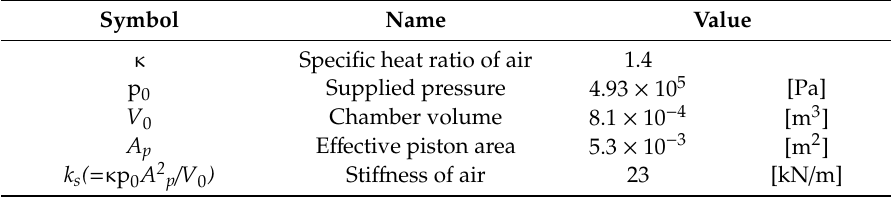
Figure 12. Experimental setup used for the measurements of the complex stiffness of pneumatic spring k *exp . Table 2. Design specifications of the employed pneumatic spring for